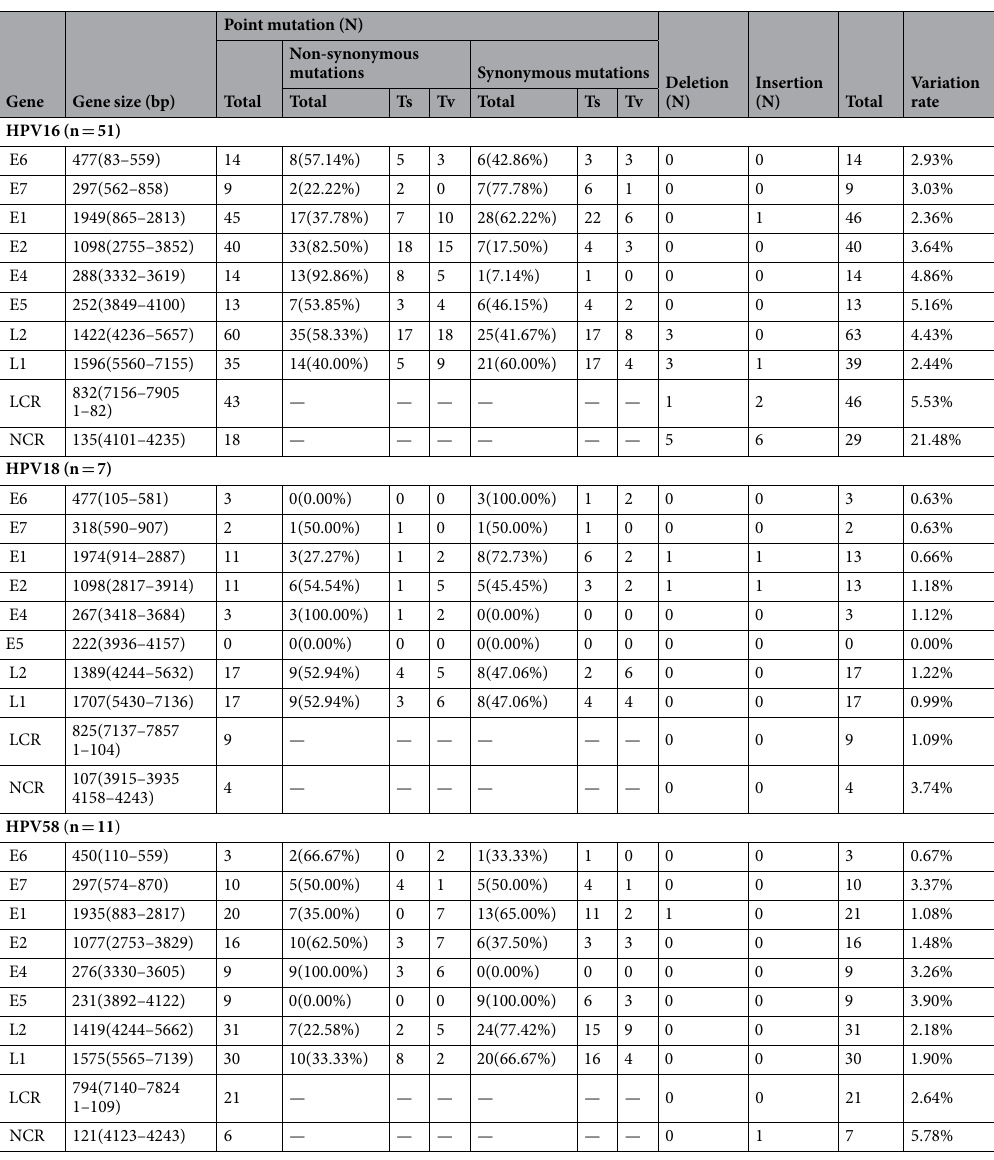
Table 1. Calculation of HPV16, 18 and 58 variations by genome region and open reading frame (ORF). Abbreviations: Ts, Transition; Tv,